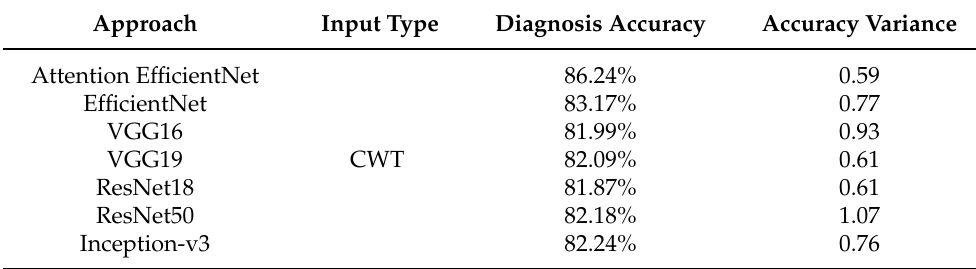
Table 8. Performance of different comparison